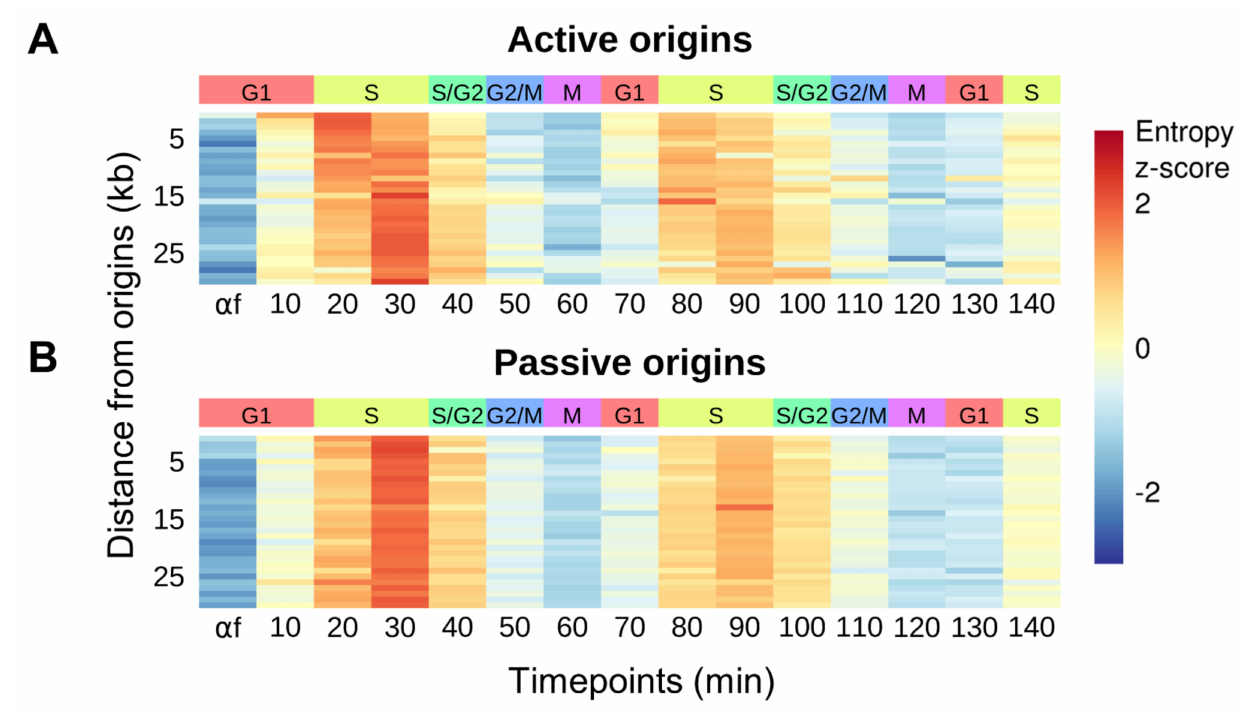
Figure 4. Nucleosome disruption at the replication fork. ( A , B ) Heatmaps representing the average nucleosome entropy at each time point in 1 kb windows for 30 kb surrounding the top 20% ( n = 69) most efficient (active) origins ( A ) and the bottom 20% ( n = 69) least efficient (passive) origins ( B ), among origins exhibiting an ORC-dependent footprint [2]. Each row represents a genomic window and rows are ordered by the distance of that window from the nearest origin. Nucleosome entropy is standardized into z-scores across each